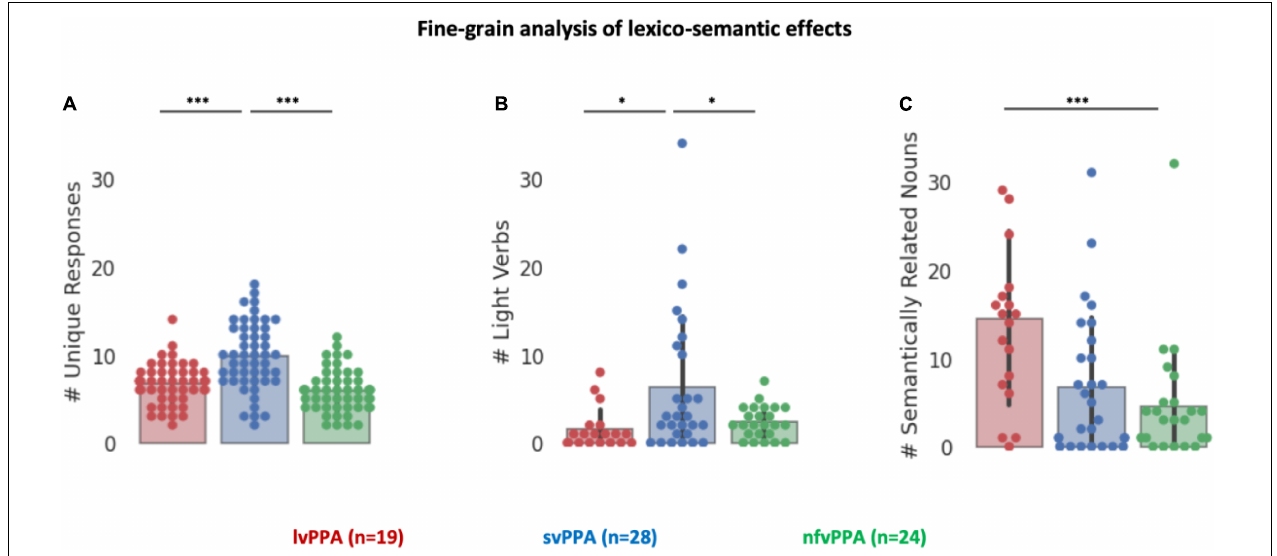
FIGURE 4 | Fine-grained analysis of lexico-semantic effects. (A) Number of unique responses produced by each patient. (B) Number of light verbs produced by each patient. (C) Number of semantically related nouns produced by each patient. Asterisk denotes a significant correlation at ∗∗∗ p < 0.001, ∗ p < 0.05.